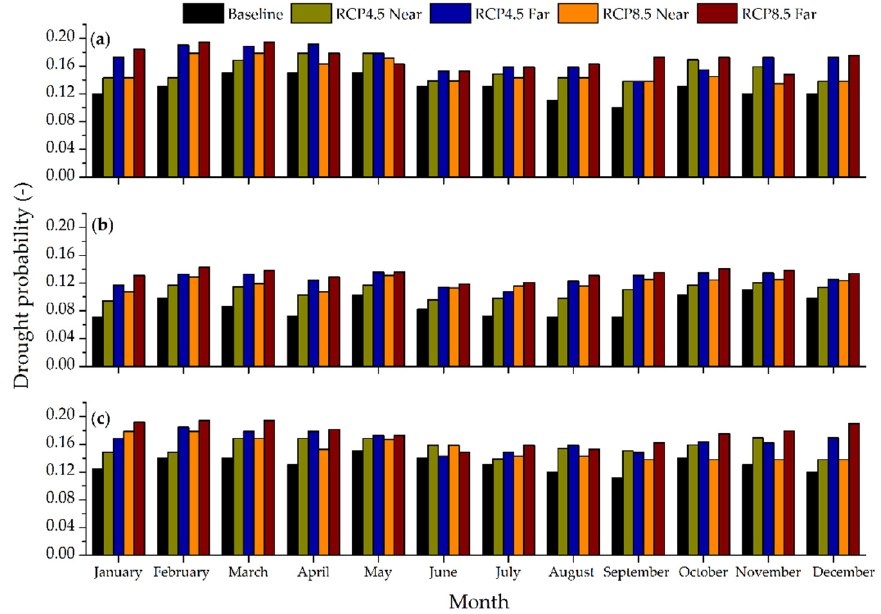
Figure 17. Probability of drought: ( a ) SPI; ( b ) SDI; and ( c ) RDI for the baseline and future periods. The ensemble averages of drought intensity for the baseline, near future, and far fu- ture periods under scenarios RCP4.5 and RCP8.5 are shown in Figure 18. The SPI findings indicate that meteorological droughts will be more intense in both future periods, with the intensity being larger in the Belg than in the Kiremt. The most severe drought intensity in the far future period would occur under RCP8.5, reaching − 1.71 to − 1.79 from October